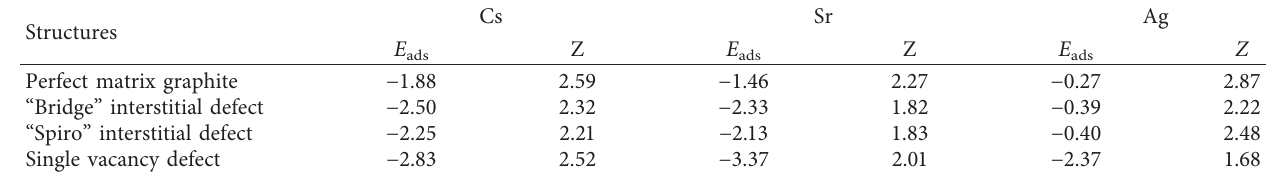
Table 1. Since the defective graphite surfaces have stronger